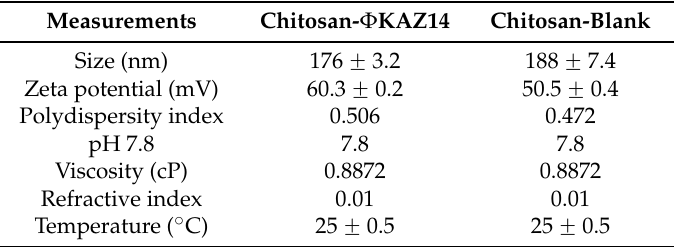
Size, zeta potential, polydispersity index, viscosity and other characteristics of the bacteriophage-based chitosan nanoformulation and blank chitosan nanoparticles.